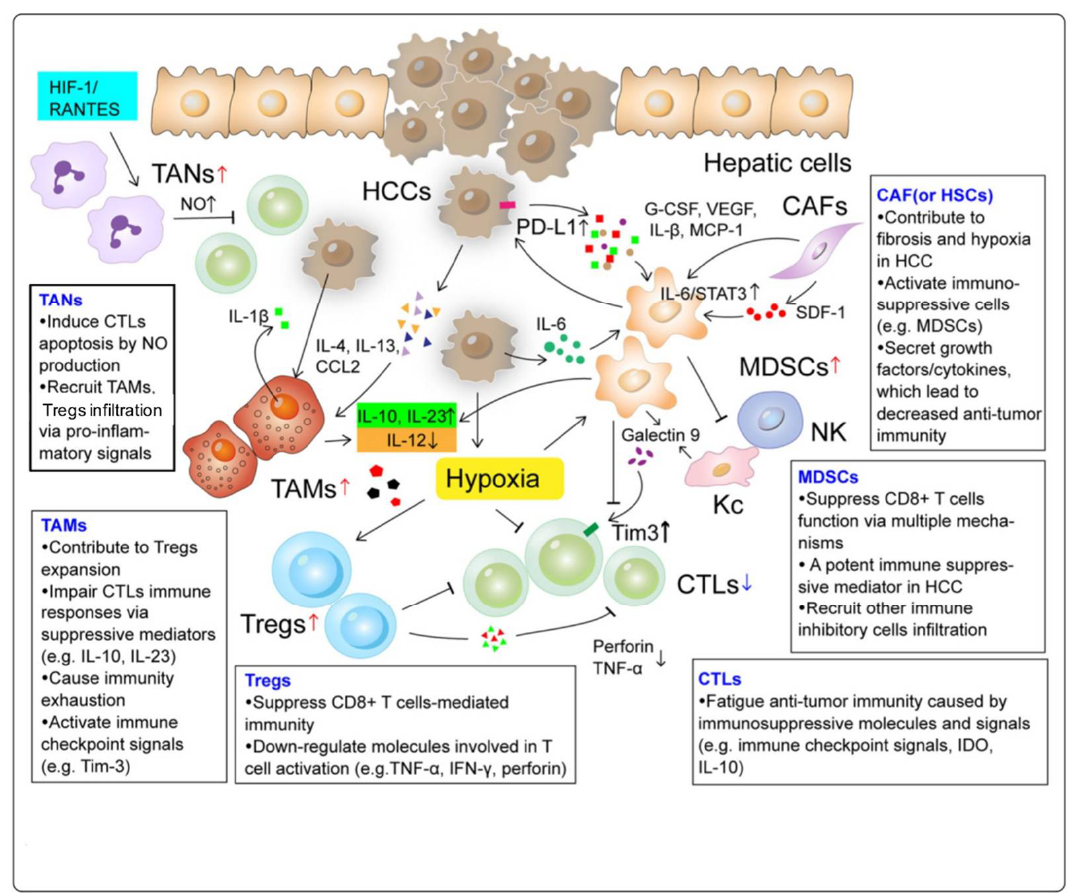
Figure 1. The landscape of an immunosuppressive tumor microenvironment.